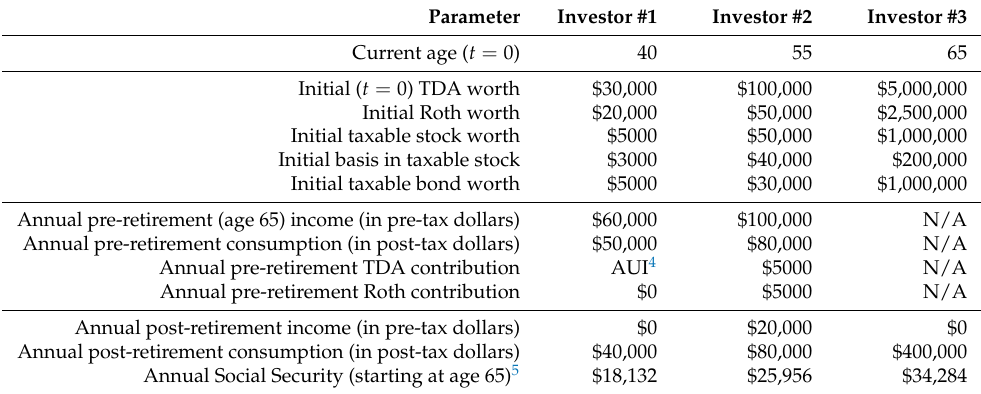
Table 3. Parameter values for the three example investors. All monetary values are in t = 0 dollars. All annual amounts adjust with inflation, which is assumed to be